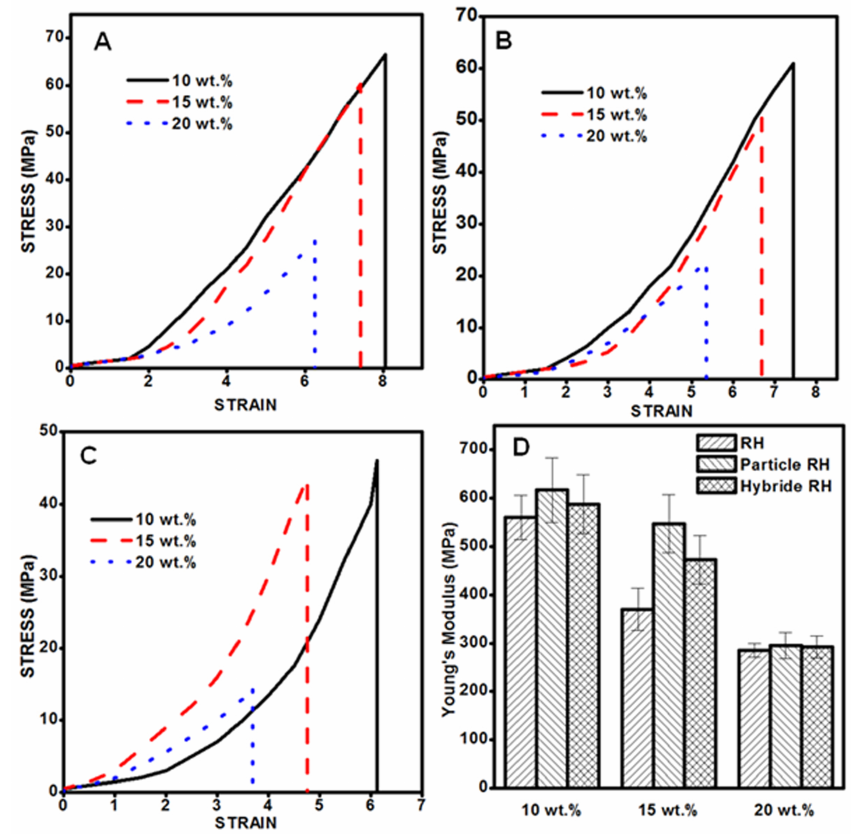
Figure 3: Stress-strain curve for epoxy based composites reinforced with (A) particle RH, (B) hybrid RH, (C) RH and (D) Young’s modulus